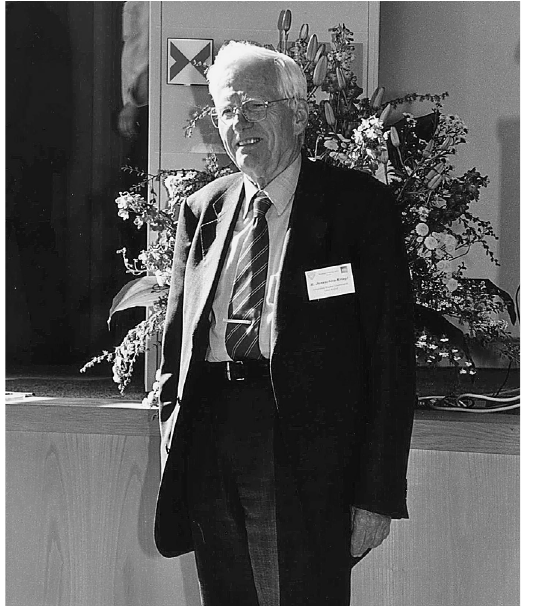
Figure 6 (right above): Prof. Hermann Janeschitz- Kriegl receiving the Honorary Membership of the